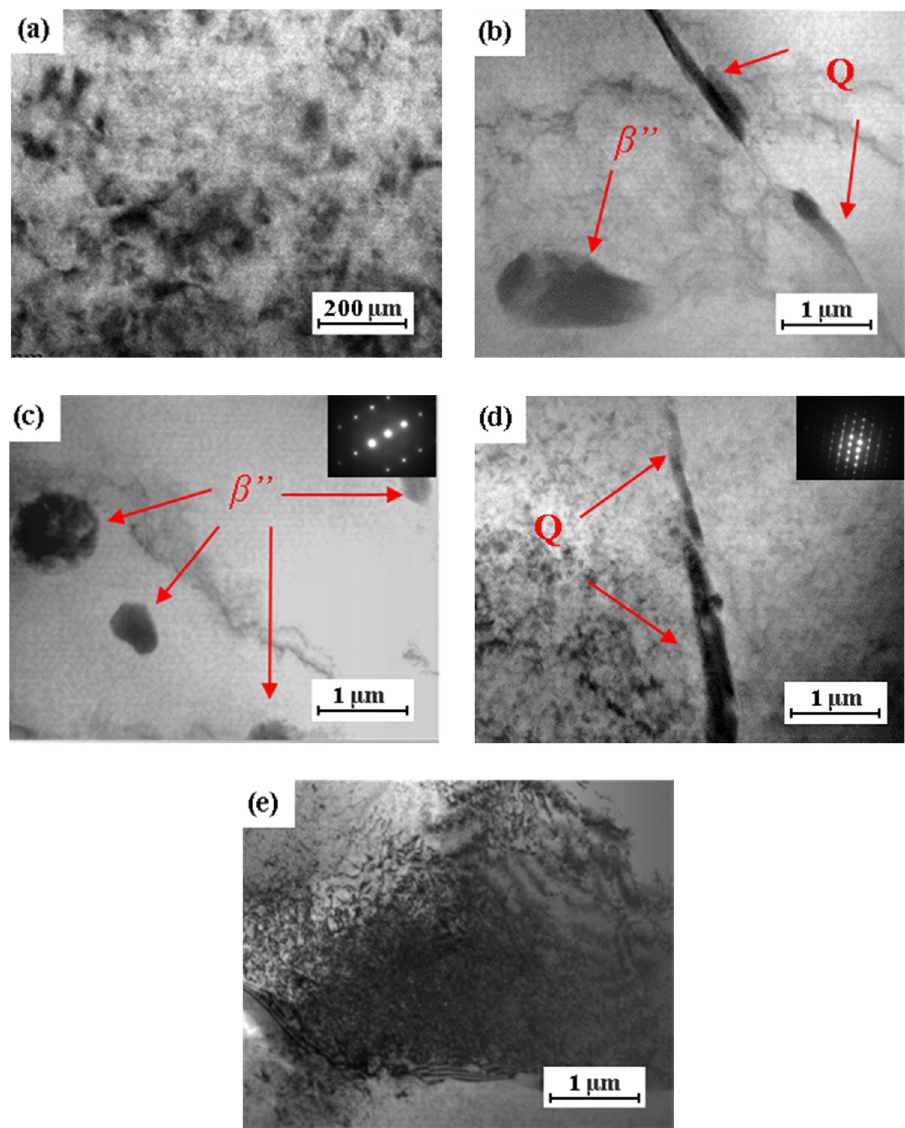
Figure 6: TEM images of the weldment: ( a ) atomic clusters in AW joint, ( b ) precipitates within grains in AW joint, ( c ) precipitated phase β ″ in the weldment of HT2 joint, ( d ) precipitated phase Q in the weldment of HT2 joint, and ( e ) dislocations in the weldment of HT2 joint.